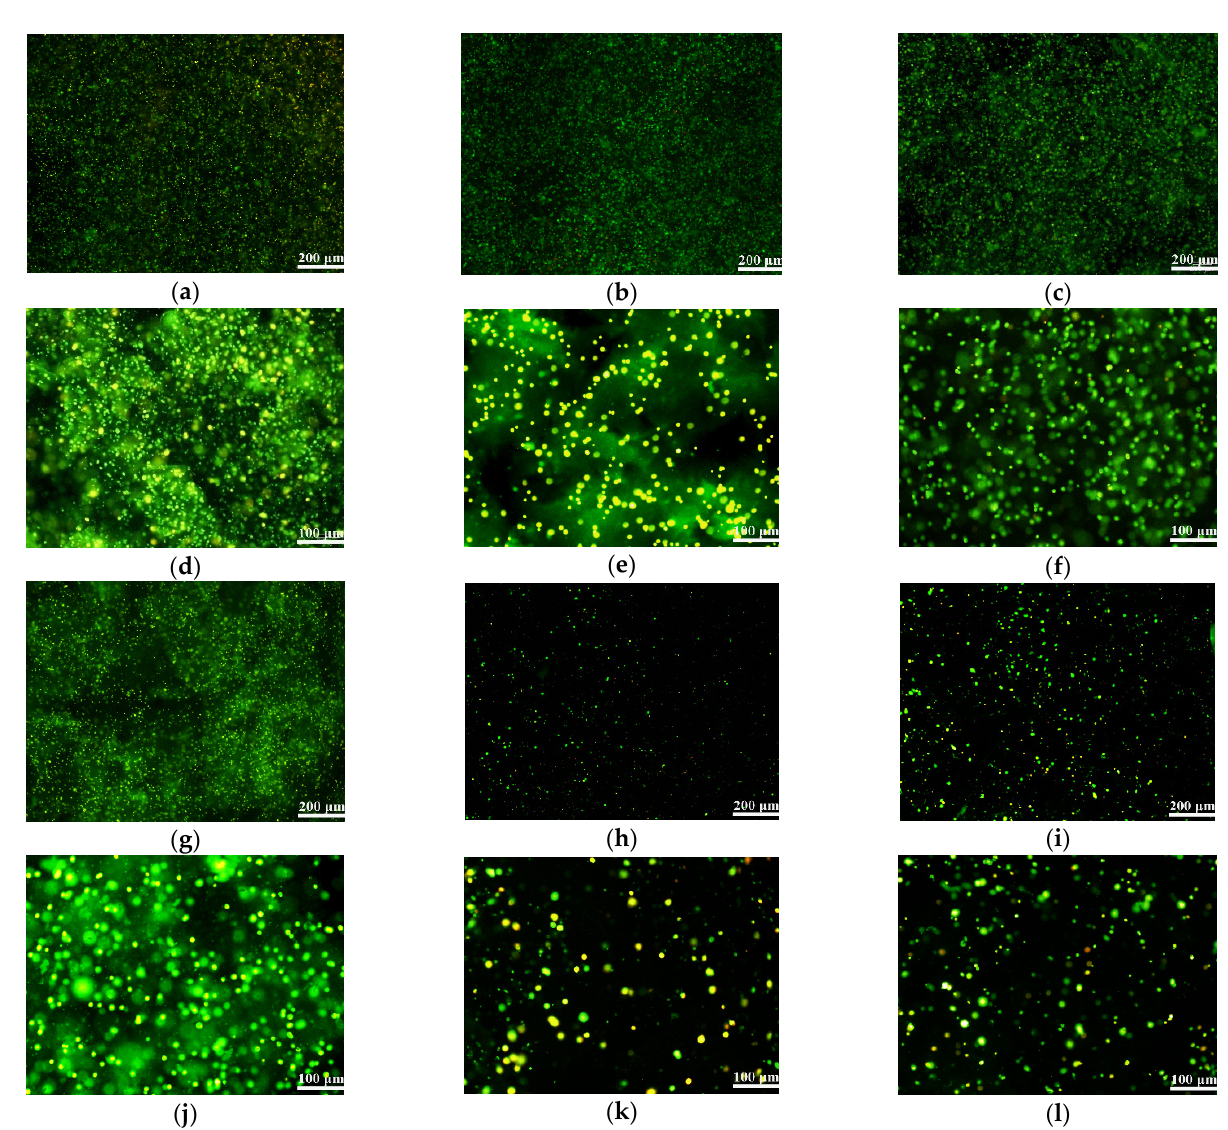
Figure 10. Laser confocal microscoope (LSM) images of AO/PI stained TCA-8113 cells embedded in hydrogels after 10 days: ( a ) G-A hydrogel: nearly all of the cells are all alive and stained in green, while several of them are stained in yellow; ( b ) G-A-A hydrogel: most of the cells are all stained in green; ( c ) F-A hydrogel: cells are all stained in green; ( d ) enlarged image of ( a ); ( e ) enlarged image of ( b ); ( f ) enlarged image of ( c ); ( g ) F-A-A hydrogel: most of the cells are alive and stained in green; ( h ) A hydrogel: a part of the cells are alive in green whereas some cells are dead in red; ( i ) A-A hydrogel: most cells are alive in green whereas several cells are dead in red; ( j ) enlarged image of ( g ); ( k ) enlarged image of ( h ), showing that some of the cells are dead in red; ( l ) enlarged image of ( i ), showing that some of the cells are dead in red.